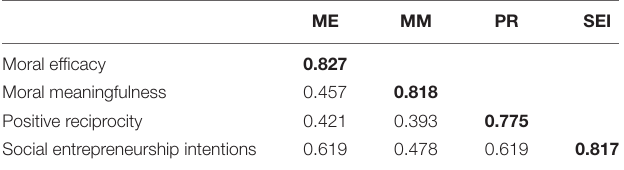
TABLE 4 | Discriminant validity.